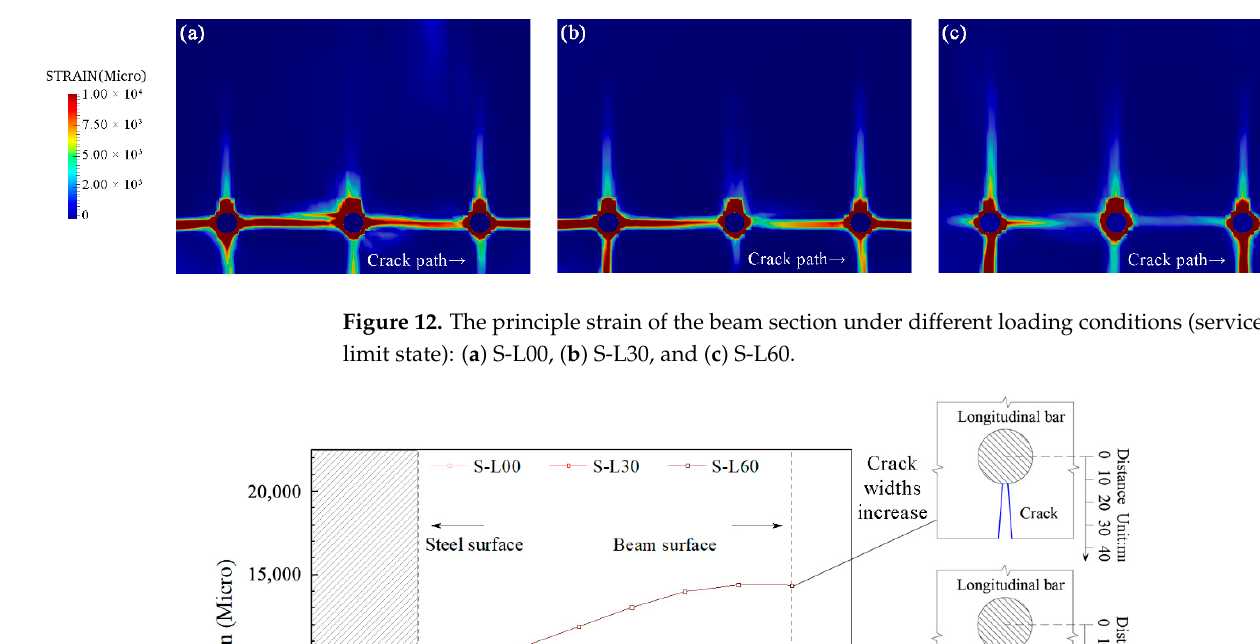
12 of 15 Figure 11. The corrosion-induced strain on the beam surface under different loading conditions (serviceability limit state): ( a ) S-L00, ( b ) S-L30, and ( c ) S-L60. The prominent effects of external loads on expediting corrosion-induced crack prop- agation in tension face are also reflected in the internal cracking pattern, as shown in Fig- ure 12. It should be noted that the beam section in the middle of the two adjacent stirrups is chosen as a research object to avoid the interference from the stirrups. Then, the princi- pal strain along the vertical crack path, marked by an arrow, is extracted, representing the potential crack width distribution, as shown in Figure 13. Because of the identical set of corrosion distributions in these three simulated beams, the crack widths on the steel sur- face under different load are much the same. The difference is that the shape of the crack varies under different load conditions. When there is no external load, the crack widths decrease along the path, showing the shape of an inverted triangle. This phenomenon can be attributed to the attenuation of corrosion-induced stress as the distance to steel surface rises, which is always found in the state before surface cracking [32]. Under 60% of the peak load, the crack expands along the path and shows the shape of a trapezoid. Obvi- ously, this phenomenon is due to the positive gradient of load-induced stress along the crack path, leading the load-induced damage in concrete becoming more severe when being close to beam surface. Moreover, the relation between the internal cracking pattern and surface crack widths is clearly reflected in the above analysis, i.e., the shape of the internal corrosion-induced cracks controls the widths of the surface crack. Compared with those corrosion-induced cracks that propagate from the steel surface to the beam surface, horizontal cracks do not connect the external environment with the longitudinal bar, and have little influence on the corrosion rate. However, as shown in Figure 12a, the horizontal cracks connecting two adjacent longitudinal bars in beam L00 together with the vertical load-induced cracks may split the section into multiple parts, weakening the cohesion in the concrete and leading to a risk of layer spalling in the tension zone [33,34]. In contrast, there are almost no horizontal cracks in beam S-L60. This phenomenon can be explained in two ways. First, the severe load-induced damage in the tension zone